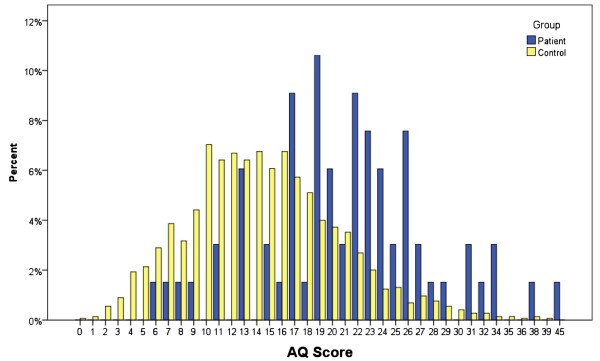
Distribution of Autism Spectrum Quotient (AQ) scores.